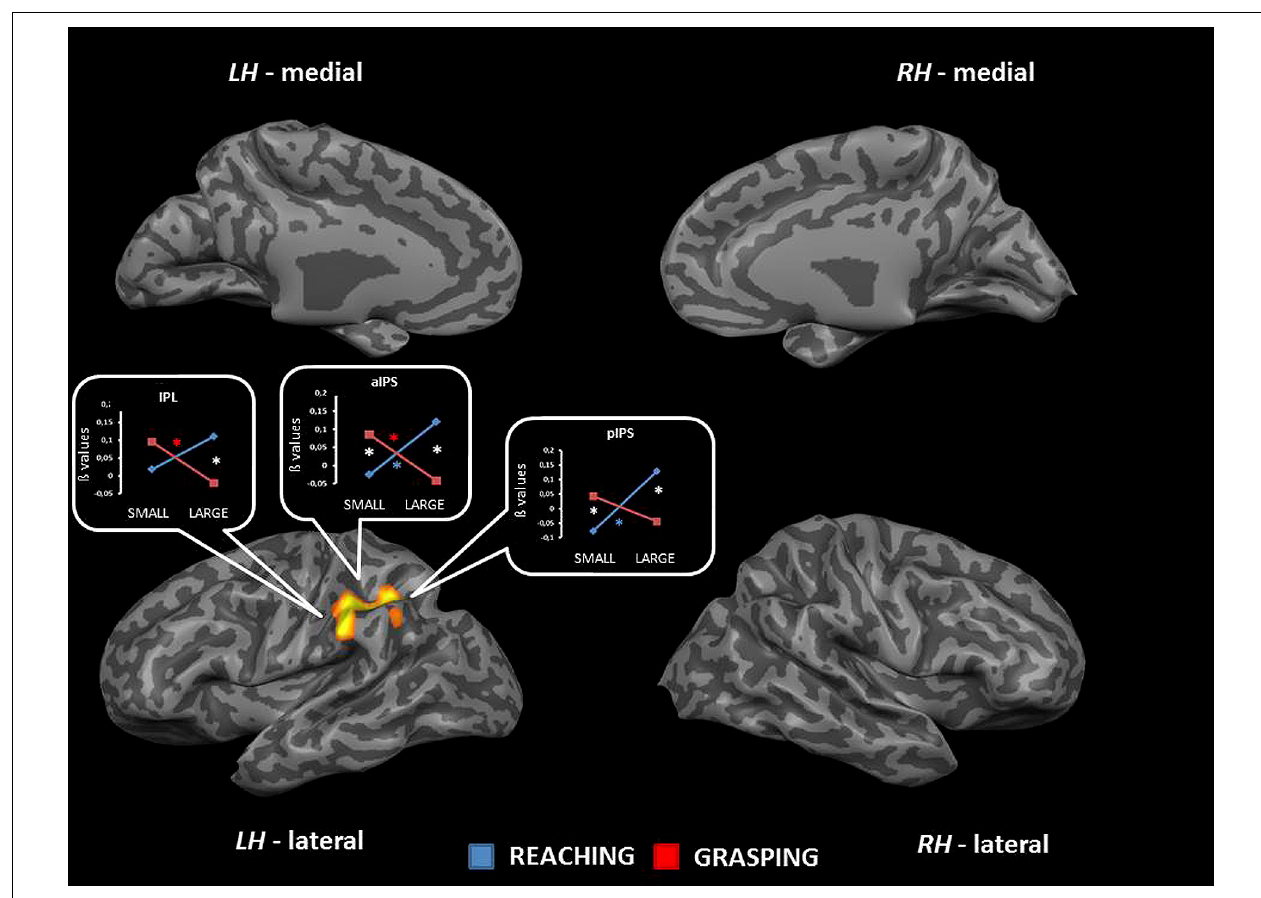
FIGURE 6 | Brain regions showing significant interaction effects between type of movement and stimulus dimension inTB 8. The p value is set to 0.001, uncorrected for multiple comparisons, cluster size k ≥ 13.White asterisks indicate significant effects for the contrast GS > RS and RL > GL;